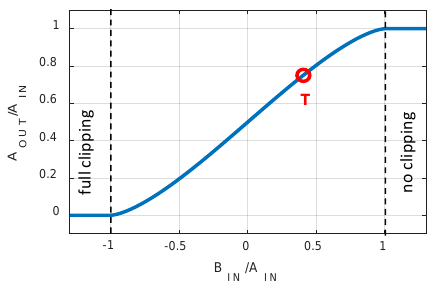
Fig. 4. Rearranged block diagram of geometric rounding mechanism with